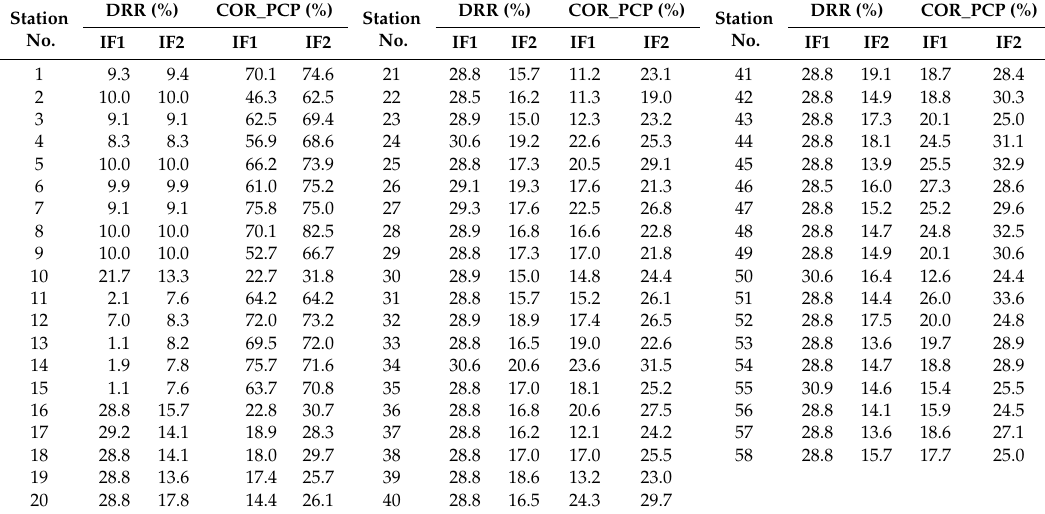
Table 2. Summary of the data removal rate (DRR) and COR_PCP values at 58 soil moisture stations. Station